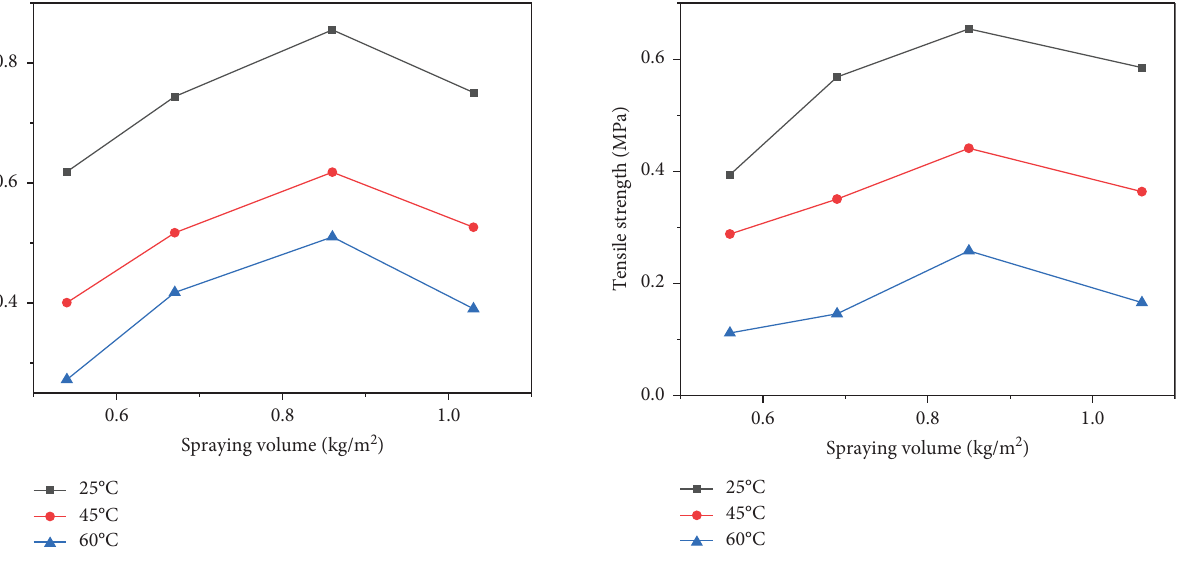
Figure 13: Variation of shear strength with temperature. Figure 14: Variation of tensile strength with